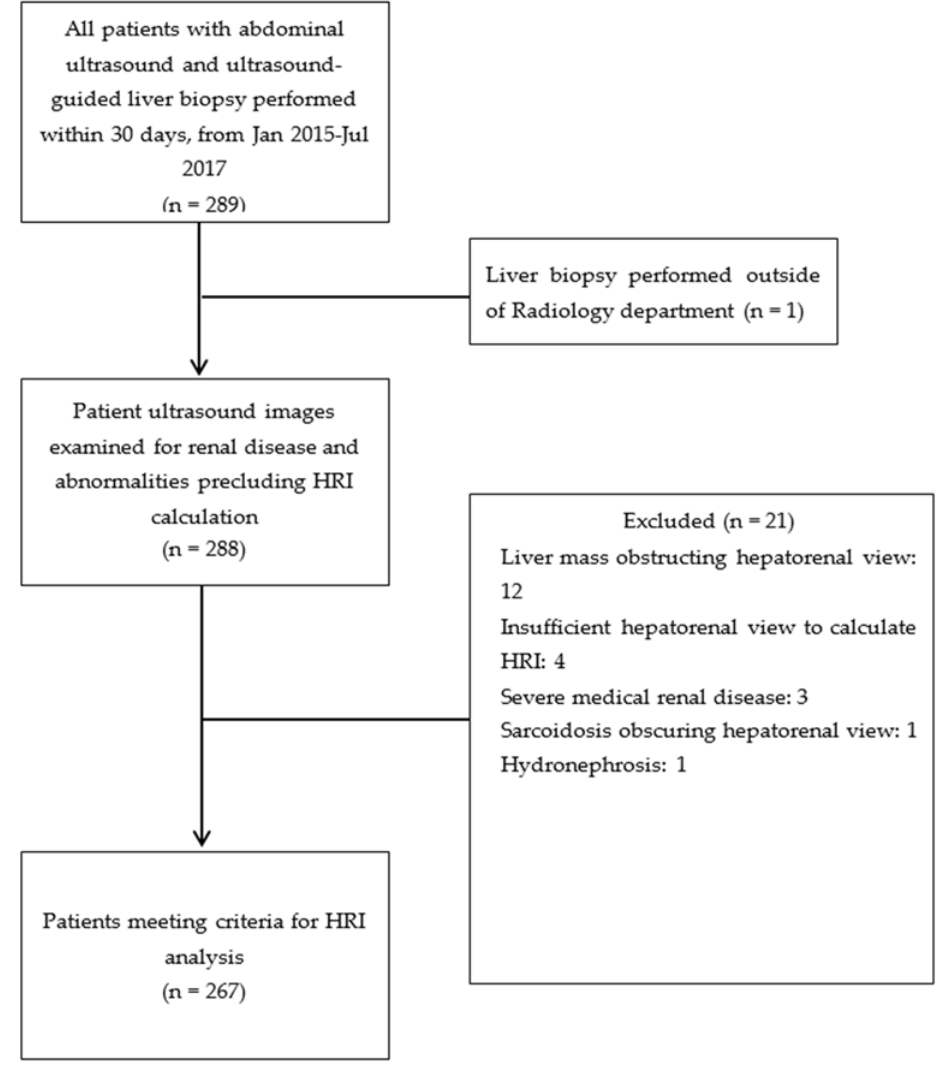
Figure 2. Diagram illustrating patient selection and exclusion. Abbreviation: HRI, hepatorenal in-